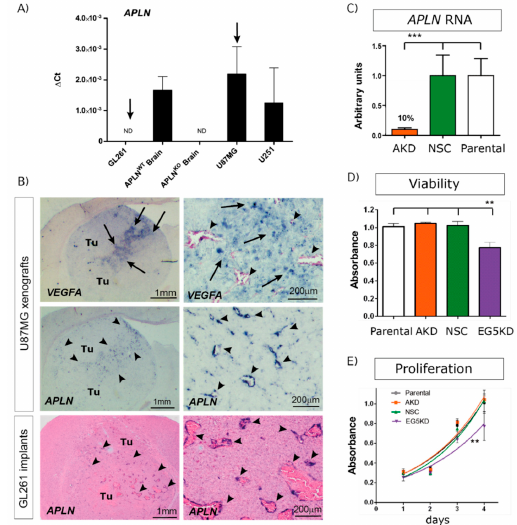
Figure 1. Angiogenic factor apelin ( APLN ) expression in glioblastoma (GBM) cells and the tumor neo-vasculature. ( A ) Expression analysis of APLN RNA was performed by qPCR on the human cells U87MG and U251, the murine GL261 cells and on APLN WT or APLN KO mouse brain tissue. APLN RNA expression was not detectable (n.d.) in GL261 cells but high in U87MG cells. ( B ) In situ hybridization against mouse APLN showed no expression in implanted mouse GL261 tumor cells but an upregulation of APLN in the tumor vessels of GL261 or U87MG gliomas (arrowheads). The right panel is the magnifications within the tumor that is depicted in the overview panel on the left. Note that vascular APLN RNA expression is highest in hypoxic regions marked by human vascular endothelial growth factor ( VEGFA ) RNA expression (arrows) in the U87MG xenografts. ( C ) Lentiviral transduction of U87MG parental cells caused shRNAmir-mediated stable APLN knock-down (AKD) by 90% (as analyzed by qPCR) compared to the non-silencing shRNA control (NSC) transduced cells. ( D ) Cell viability, as well as in vitro proliferation ( E ), was unchanged in U87 AKD cells compared to U87 NSC control or untransduced U87MG cells. In contrast, U87 cells transduced with the shRNA against the kinesin EG5 significantly reduced viability and proliferation of U87 E5KD cells compared to U87 NSC control. Data are obtained from more than 3 independent experiments each and reported as mean +/ -SEM; statistical significance (one-way ANOVA plus Bonferroni’s post hoc test) is indicated ** p < 0.005, *** p < 0.0005. WT = wildtype; KO =